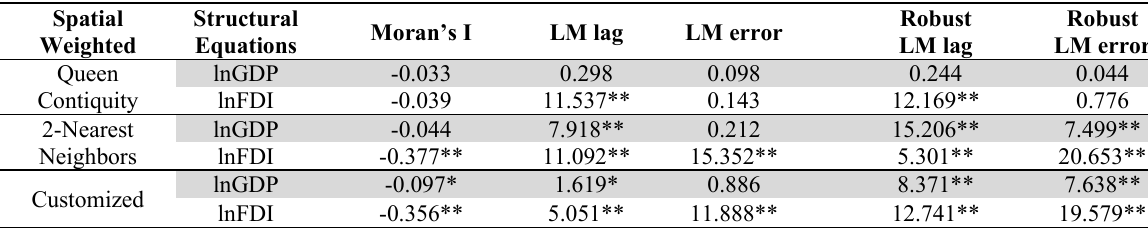
Residual spatial dependency test